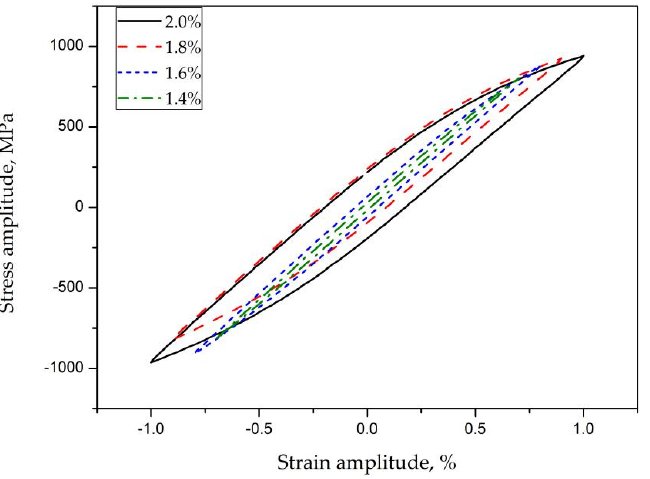
Figure 6. The superimposed hysteresis loops of the specimens at different strain levels for TC21